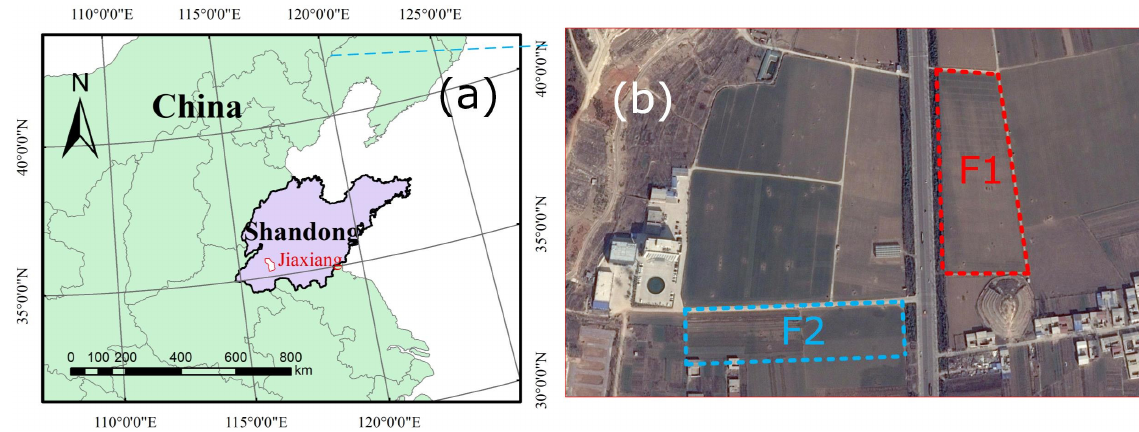
Figure 1. Study area ( a ) and experimental soybean field ( b ).